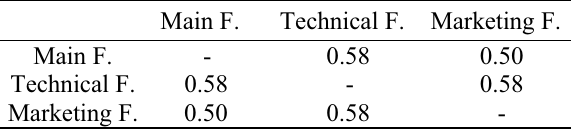
Table 2. Consistency level matrix for the assessment of member